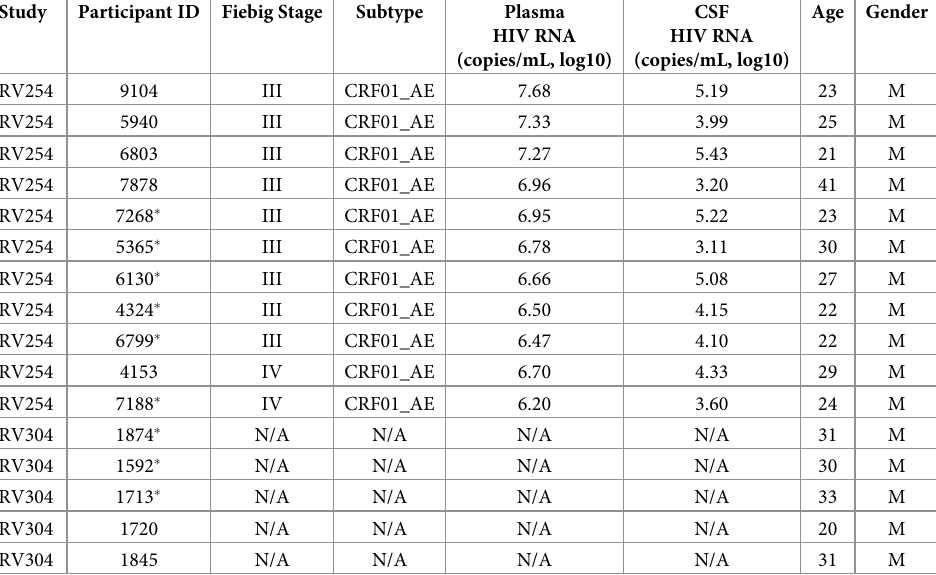
Table 1. Demographic and clinical characteristics for people living with acute HIV Infection and for people with- out HIV.